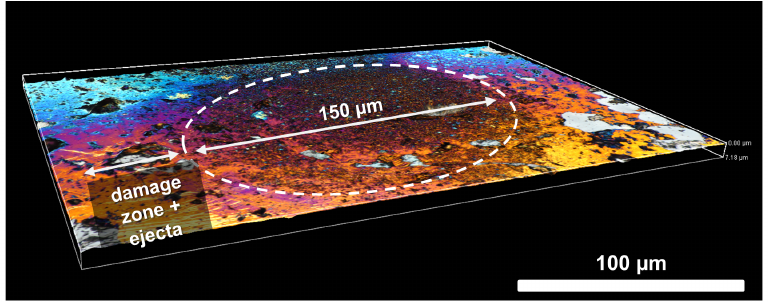
Figure 15. Reflected light three-dimensional (3D) step image of a LIBS crater in chalcopyrite (outlined in white). The ablation depth in copper sulfide minerals is 1–5 µ